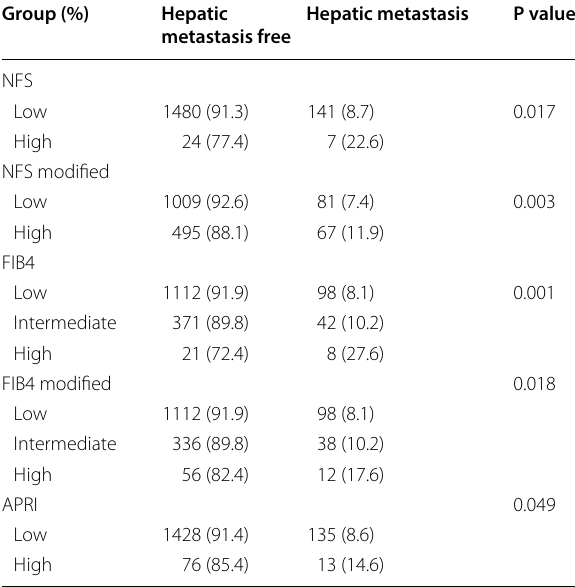
Table 2 Prevalence of any hepatic metastasis in cohorts stratified by NFS, FIB4 and